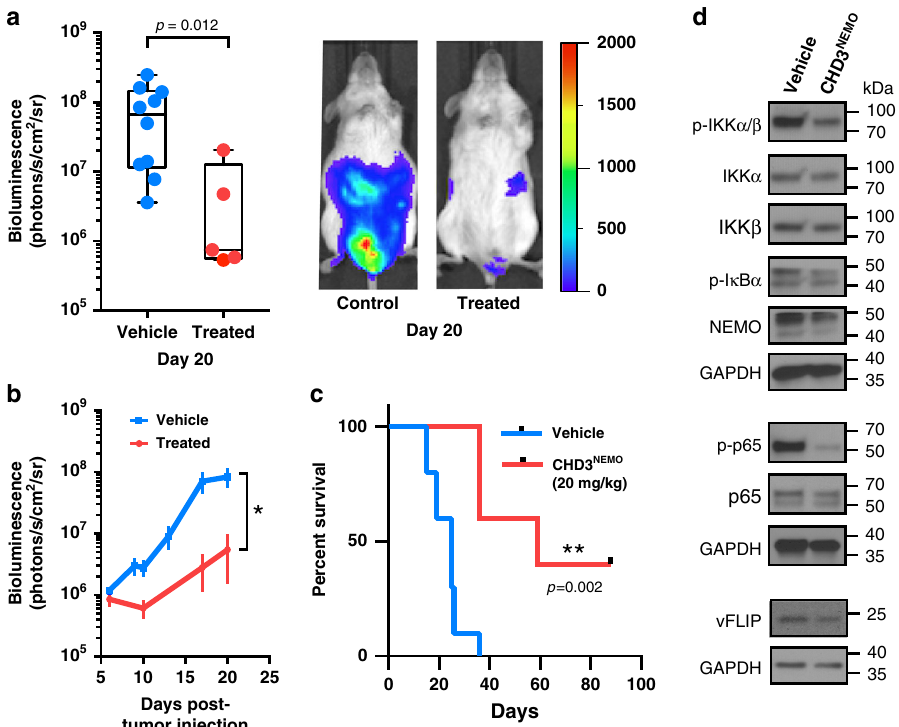
Fig. 6 Effect of CHD3 NEMO on tumor growth in a traceable reporter BC-3-Luc PEL xenograft mouse model. a Box- and Whisker plots of relative tumor burden at day 20 post-engraftment quanti fi ed using bioluminescence imaging. Statistical analysis was performed using two-sided Mann Whitney test ( p = 0.012, * p ≤ 0.05). One representative mice for each group is presented (right). Box and whisker plots represent all individual data points within the /min-max range (vehicle n = 10 and treated n = 5). b Bioluminescence quantitation representing tumor burden (mean ± SEM) after 20 days of tumor engraftment in the vehicle-treated (blue line, n = 10) versus CHD3 NEMO treated group (red line, n = 5). Statistical analysis was performed using two-sided Mann Whitney test ( p = 0.012, * p ≤ 0.05). c Kaplan-Meier survival analysis showing that mice treated with the CHD3 NEMO peptide (in red) has a survival